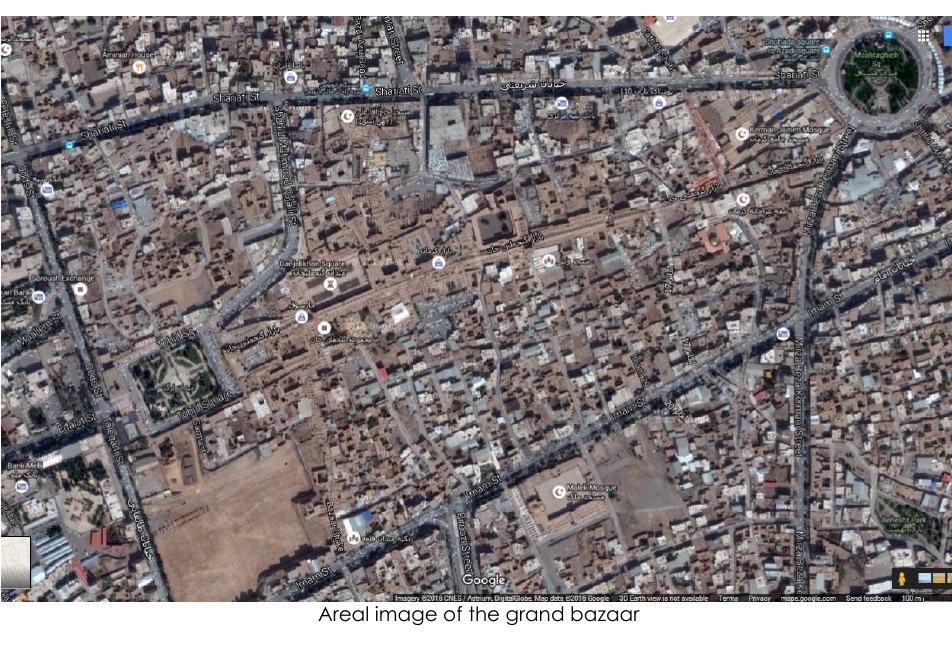
Figure 2. The map of the main of Grand Bazaar and its open public spaces